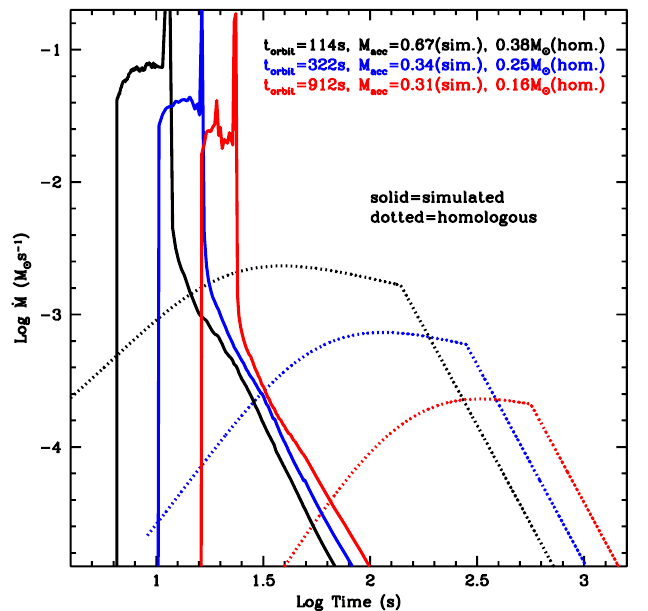
Figure 3. Hypercritical accretion rate onto the NS companion for selected separation distances. The CO core is obtained with a progenitor star of zero-age main-sequence (ZAMS) mass of 20 M calculated in [83]. The numerical calculation leads to a sharper accretion profile with respect to the one obtained assuming homologous expansion of the SN ejecta. Taken from Figure 3 in